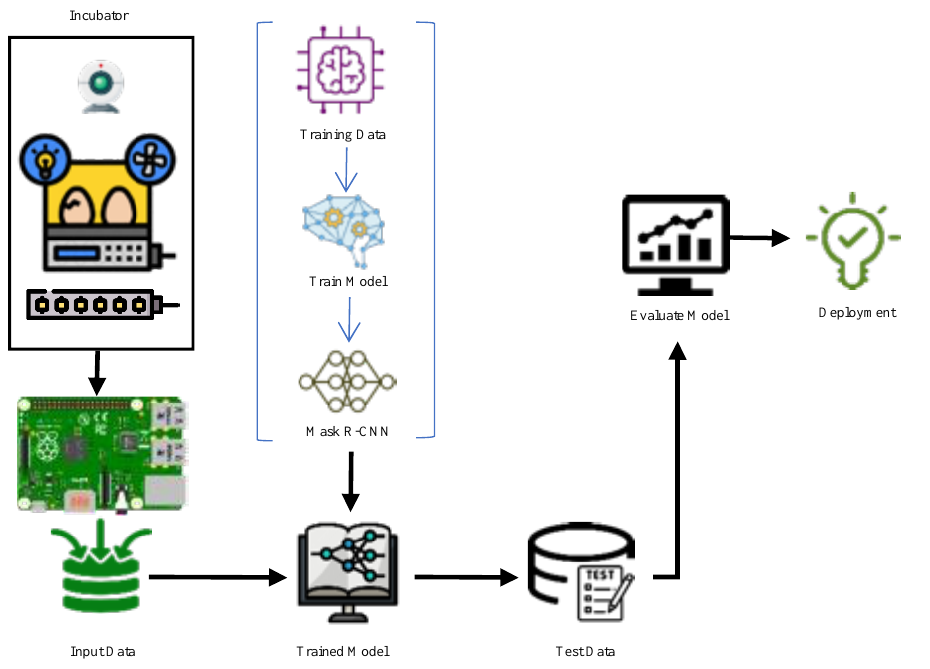
Figure 1. Working phases of the proposed system.